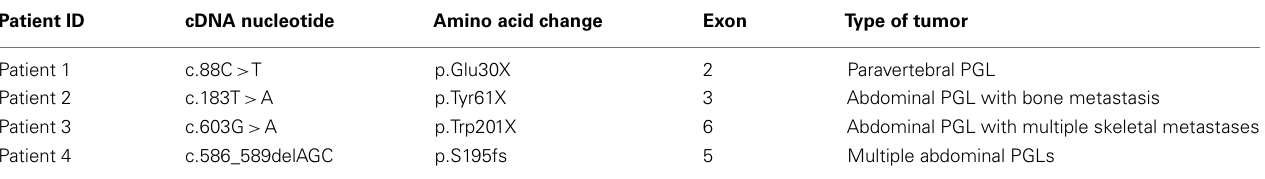
Table 1 | Germline mutations affecting SDHB and related